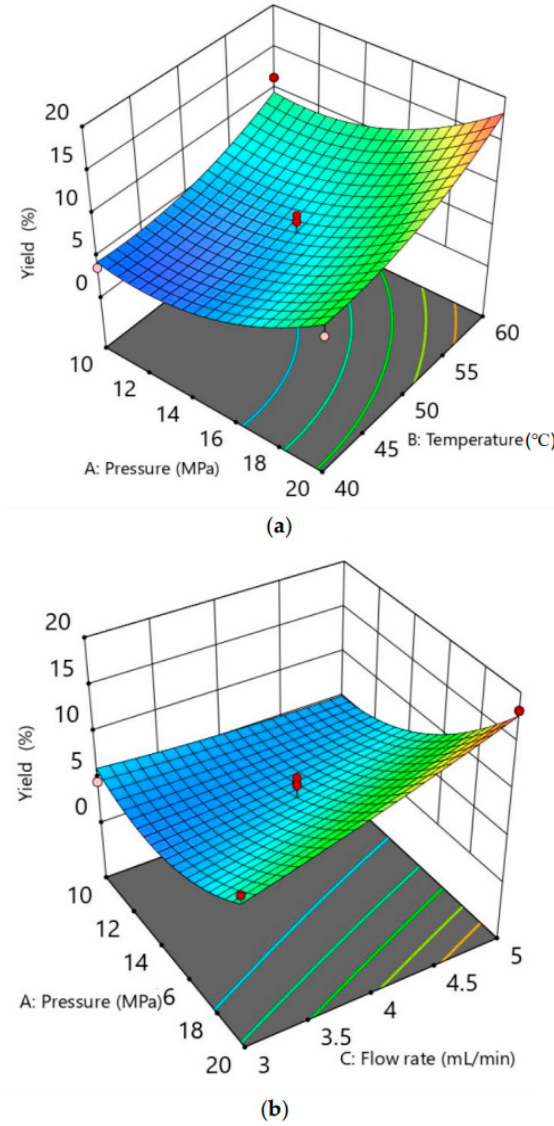
Figure 2. The effect of ScCO 2 ′ s variables on total yield, % ( a ) effect of pressure and temperature at constant flow rate; ( b ) effect of pressure and flow rate at constant temperature.